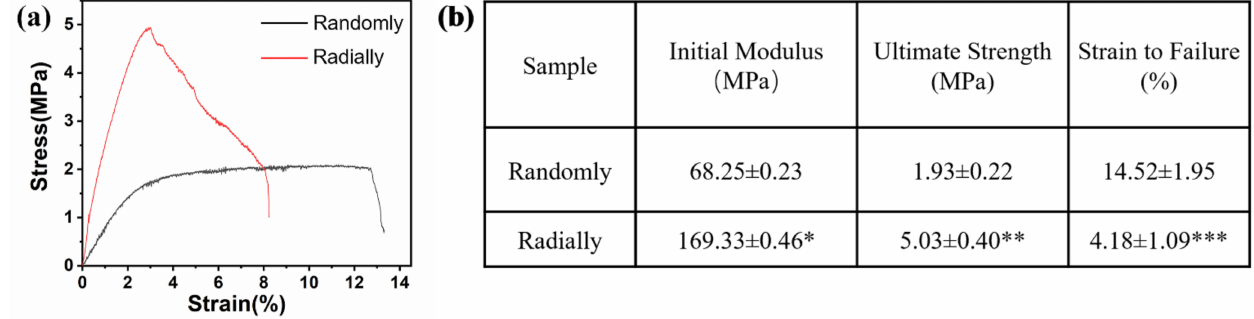
Figure 6. Mechanical properties of as-prepared PHBV nanofiber scaffolds with both randomly and radially oriented patterns: ( a ) representative tensile stress–strain curves; ( b ) analysis of some specific mechanical parameters (n = 5; * p < 0.05, ** p < 0.01, *** p <